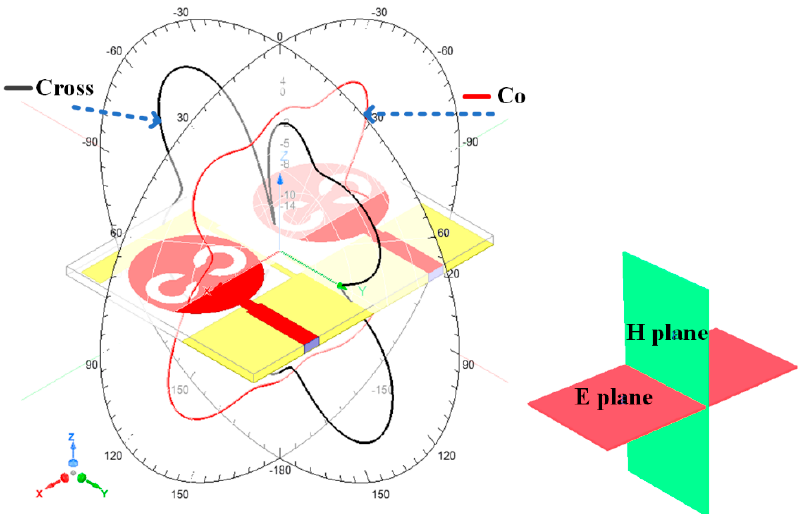
Figure 2. Representation of co − and cross − polarization plane to its axis system for design 4 antenna system with both port excitation conditions with E and H plane notation.